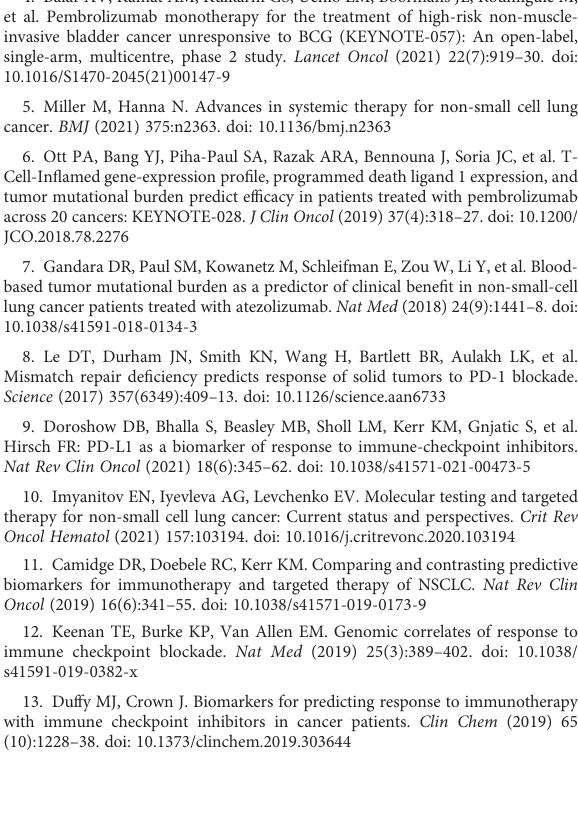
SUPPLEMENTARY FIGURE 2 Differences in pathway activities scored by GSEA between PTPRD/ PTPRT mutant and WT tumors in TCGA dataset and the most relevant enrichment pathways are shown in the above fi gure. Blue bars mean that the enrichment score (ES) of the pathway is more than 0. Conversely, yellow bars mean that the ES of the pathway is less than 0.